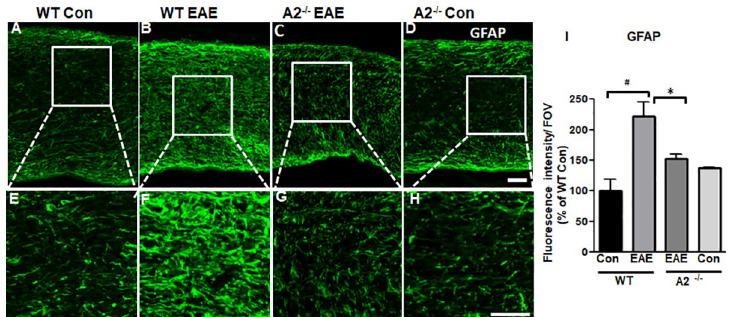
Fig 6. EAE-induced astrogliosis is reduced in A2 deficient optic nerves. A-D) Representative confocal images optic nerve sections demonstrate the activation of astrocytes (labeled by GFAP antibody) in the WT EAE optic nerves while the deletion of A2 significantly suppressed the extent of astrogliosis. E-H) Magnified images of respective boxed areas in A-D demonstrate hypertrophic astrocytes. I) Quantification of glial activation in optic nerve sections of different groups. Scale bar 50 μ m. Number of animals used: 8(WT Control); 12 (WT EAE); 9 (A2 -/- EAE); 7 (A2 -/- Control). Representative images are presented. Data are presented as mean ± SEM. #p < 0.01 WT EAE vs WT Con and � p < 0.05 A2 -/- EAE vs WT